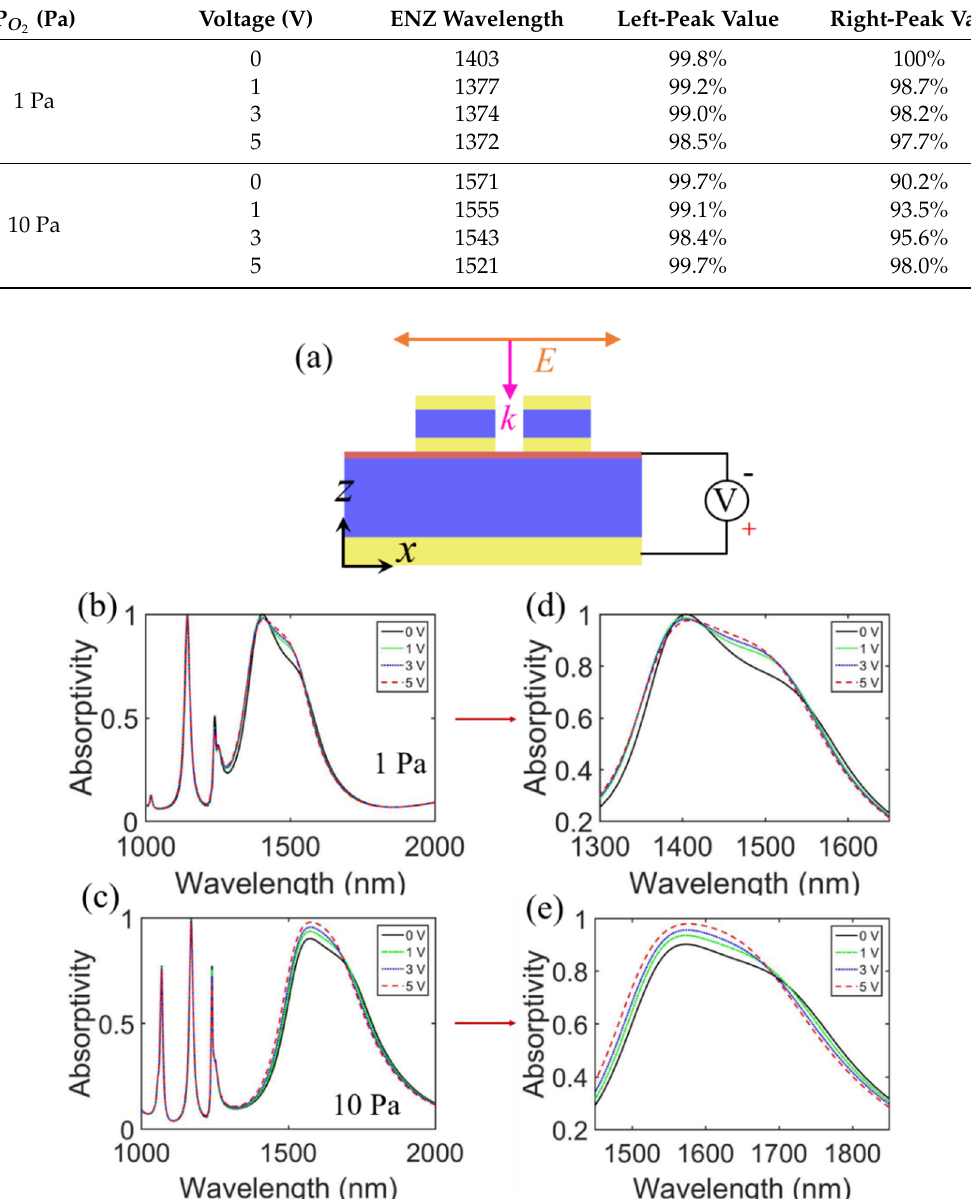
Figure 7. ( a ) Schematic of the MIMIM stacked structure with an applied gate voltage V. ( b ) and ( c ) represent the absorptivity with different applied gate voltages for ITO thin films deposited at 1 and 10 Pa. ( d ) and ( e ) are zoom ‐ in views of ( b ) and ( c ), respectively.